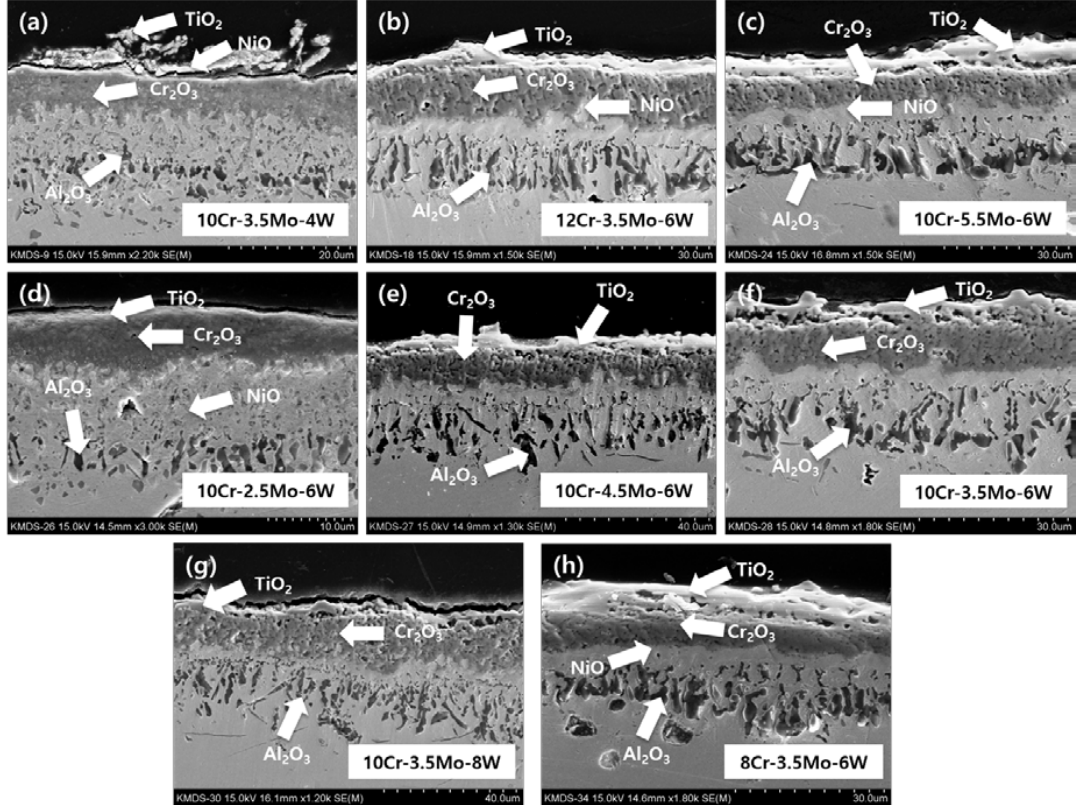
Figure 6. Cross-sectional image of ( a ) 10Cr–3.5Mo–4W, ( b ) 12Cr–3.5Mo–6W, ( c ) 10Cr–5.5Mo–6W, ( d ) 10Cr–2.5Mo–6W, ( e ) 10Cr–4.5Mo–6W, ( f ) 10Cr–3.5Mo–6W, ( g ) 10Cr–3.5Mo–8W, ( h ) 8Cr–3.5Mo–6W alloys oxidized at 1000 °C.